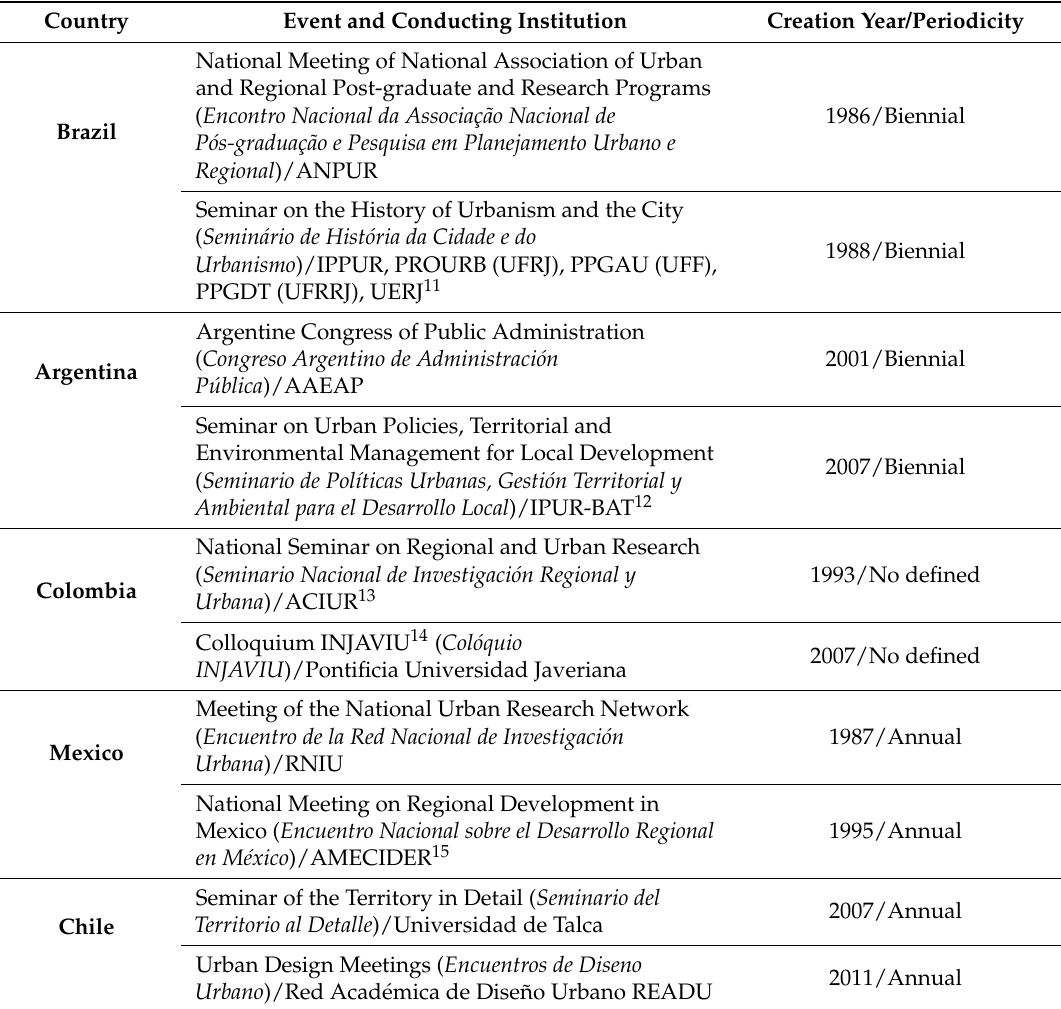
Table 2. Reference events in urban and regional planning/cities in selected countries of Latin America (past eight